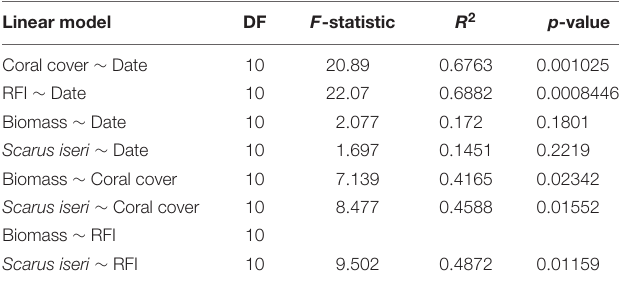
TABLE 5 | Linear models of the different variables used during 12-months period of study.